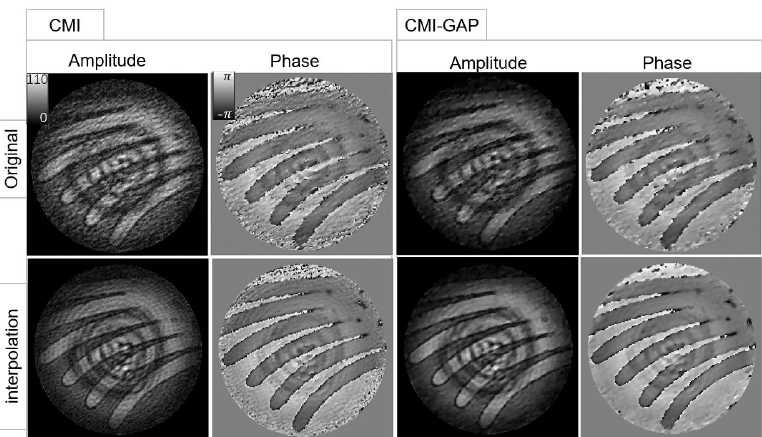
Figure 9. Reconstruction of the far-field CMI experimental data. Top-left: Reconstructed amplitude and phase with original algorithm. Top-right: Reconstructions with proposed algorithm. Bottom-left: Reconstructions of original algorithm with 2 × 2 subdivision. Bottom-right: Reconstructions of proposed algorithm with 2 × 2 subdivision.